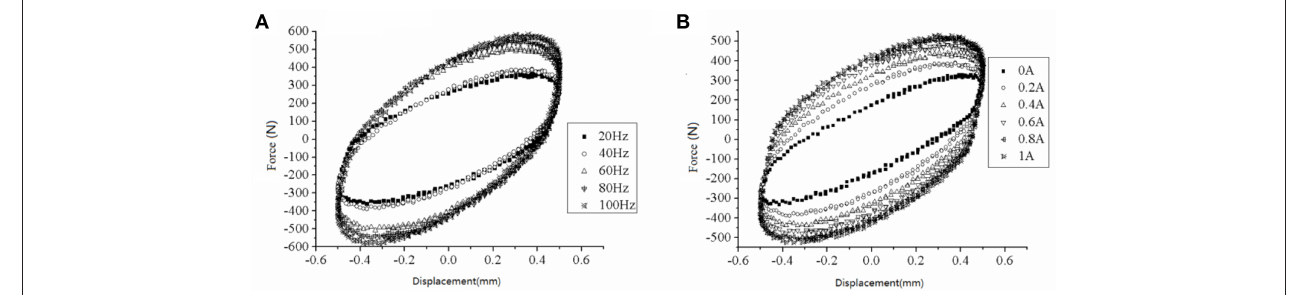
FIGURE 8 | The force-displacement relationship of MR fluid mounts (A) in different excitation frequency (B) in different currents.